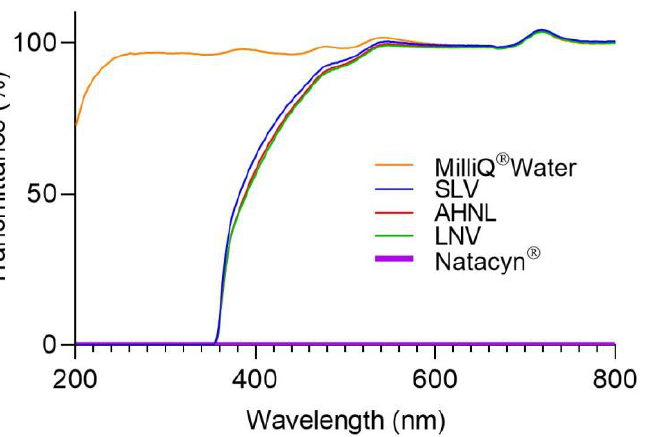
Figure 6. Scan light transmittance from 200 to 800 nm for the formulations including natamycin. MilliQ ® water was used as a transparent formulation in all light ranges.